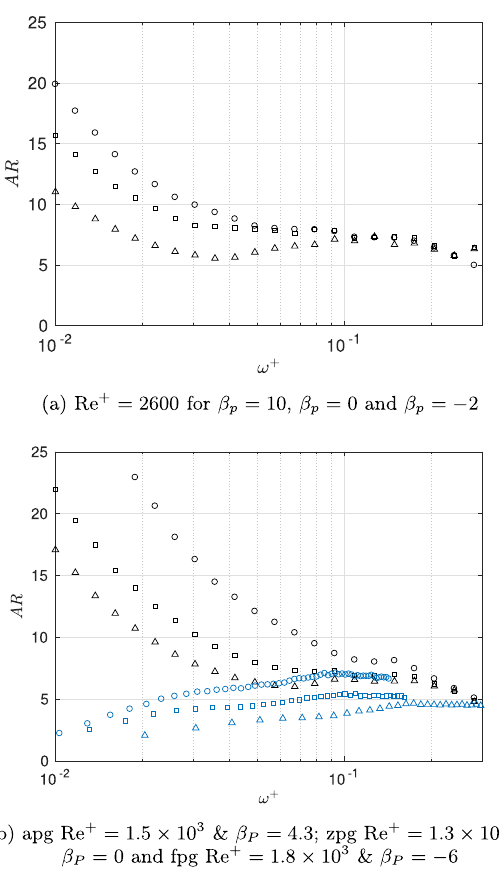
Figure 9. Aspect ratio of the half level contour for apg ( D ), zpg ( h ) and fpg ( s )